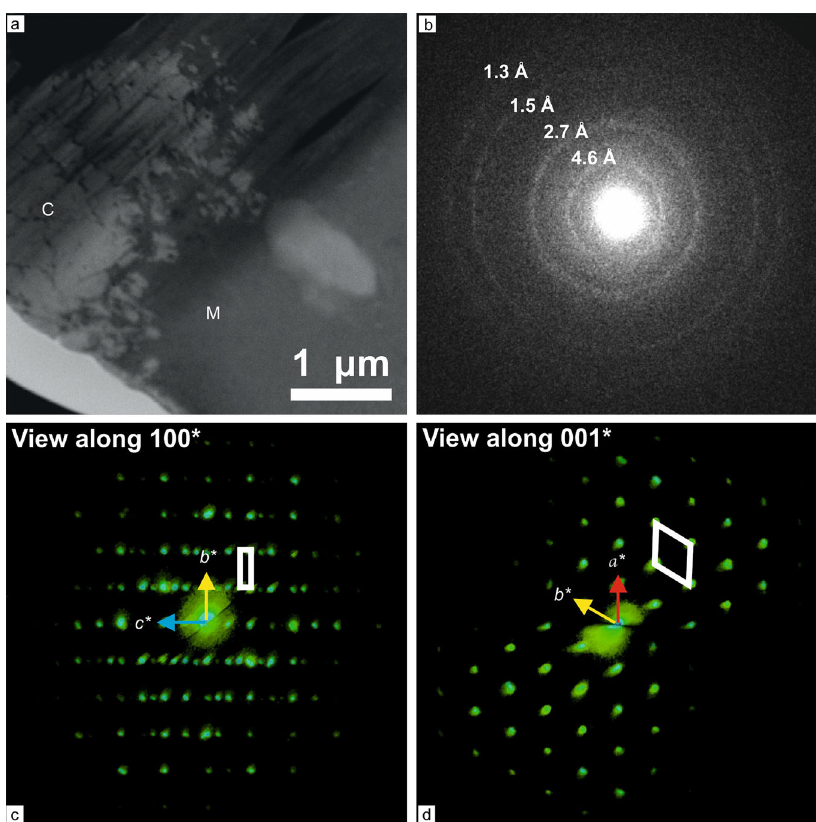
Fig. 7 TEM and electron diffraction analysis of high-Mn calcite – Mg-clay interface. a Image of a FIB lamella showing the typical contact between nanocrystalline high-Mn calcite (labeled ‘ C ’ and nanocrystalline-to-amorphous Mg-clay (M). b Polycrystalline SAED pattern originating from the Mg-clay. Rings correspond to typical hk0 interplanar distances of T-O phyllosilicates. c Projection along reciprocal axis a * (100*) and d projection of 3D diffraction volume along reciprocal axis c * (001*) of reconstructed 3DED data taken from a single high-Mn calcite crystal of few hundred nanometers in size. Reciprocal cell edges are sketched as